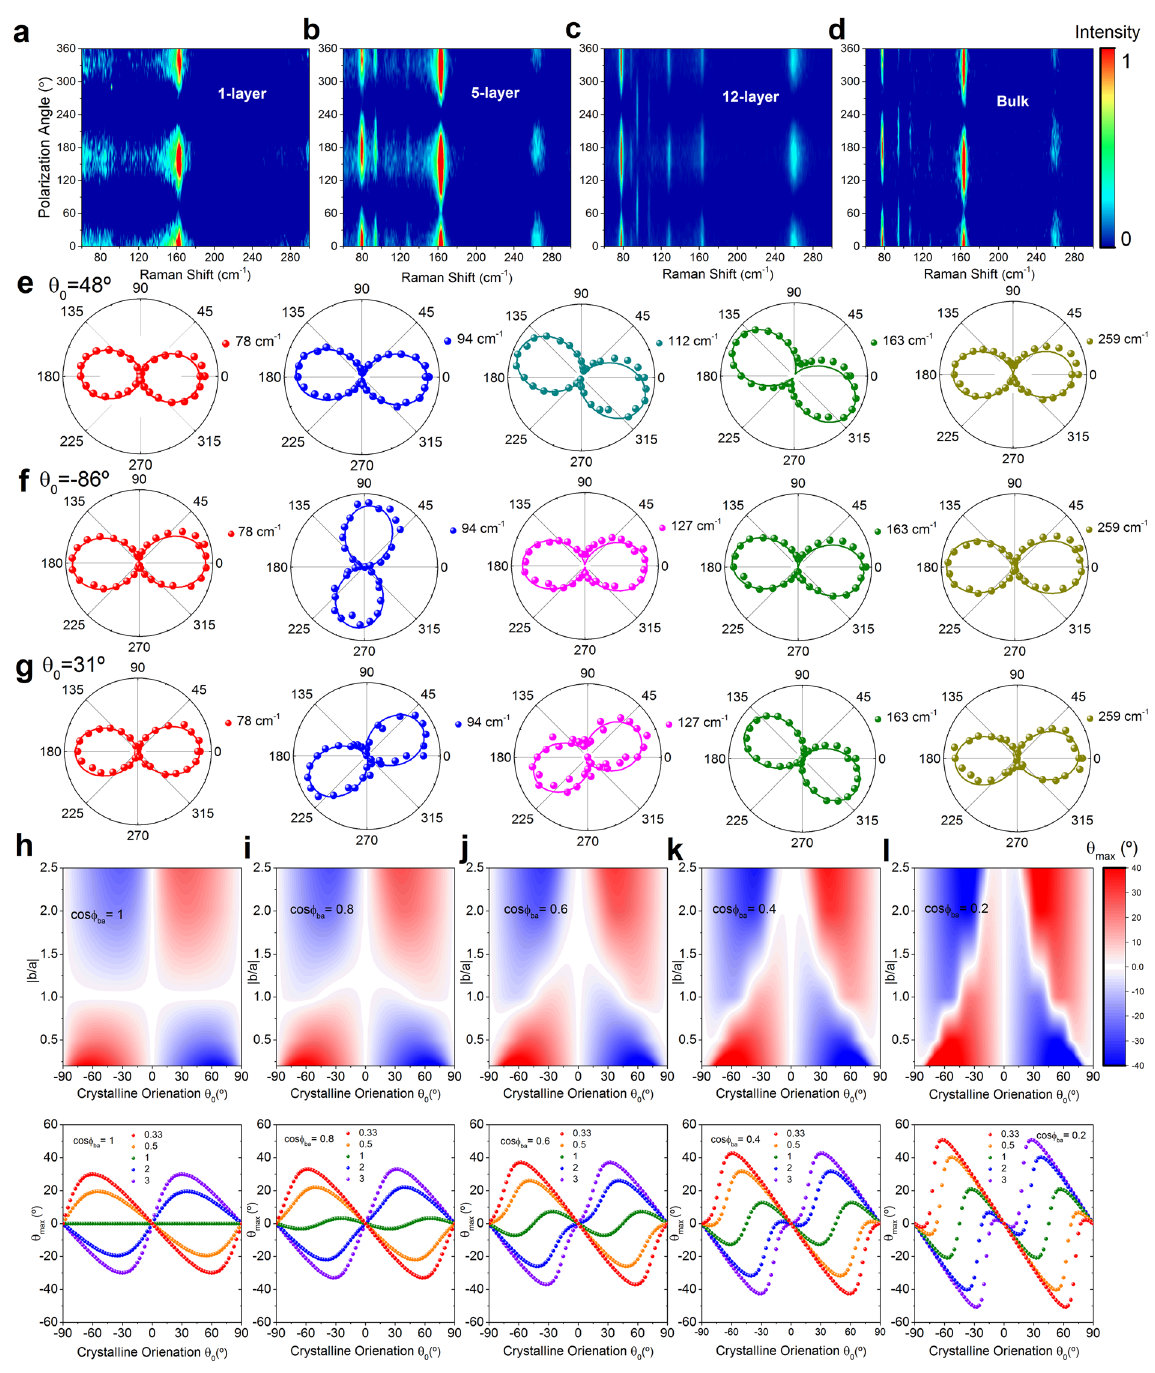
Figure 3. The rotation of the incident laser polarization dependent Raman spectra of ( a ) 1-layer, ( b ) 5-layer, ( c ) 12-layer and ( d ) bulk 1 T´-MoTe 2 , the initial incident polarization is parallel to the scattered polarization. Each spectrum has been normalized to its maximum intensity, respectively. The polar plots of the three detected mode types for ( e ) 5-layer, ( f ) 12-layer and ( g ) bulk 1 T´-MoTe 2 samples. The calculated θ max as a function of θ 0 and | b / a |, where the value of cos 𝜙 ba is ( h ) 1, ( i ) 0.8, ( j ) 0.6, ( k ) 0.4, and ( l ) 0.2. The corresponding relation between θ max and θ 0 with certain | b / a | (0.33, 0.5, 1, 2 and 3) is plotted below each